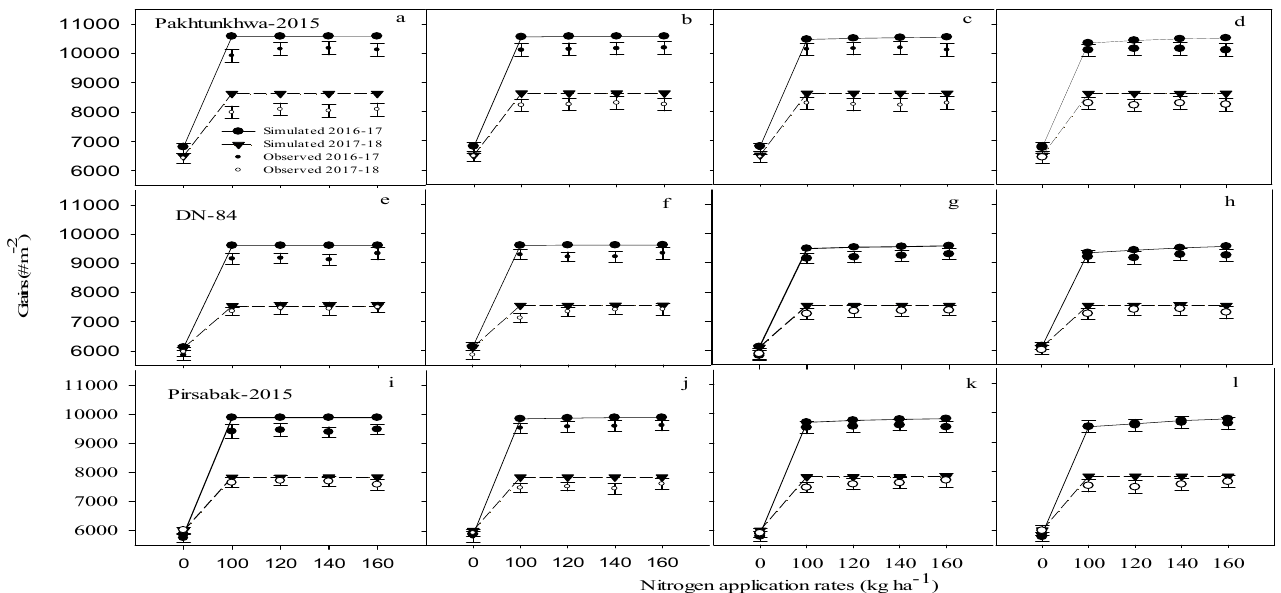
Figure 3. Using SM-CERES-Wheat to predict number of grains (m − 2 ) as a function of N application at different stages: full N application (N 100% ) at sowing ( a , e , i graphs), half of recommended N application (N 50% ) at sowing + N 50% at tillering ( b , f , j graphs), quarter of recommended N application (N 25% ) at sowing + N 50% at tillering + N 25% at booting ( c , g , k graphs), and N 25% at sowing + N 25% at tillering + N 50% at booting stage ( d , h , l graphs) for different cultivars.